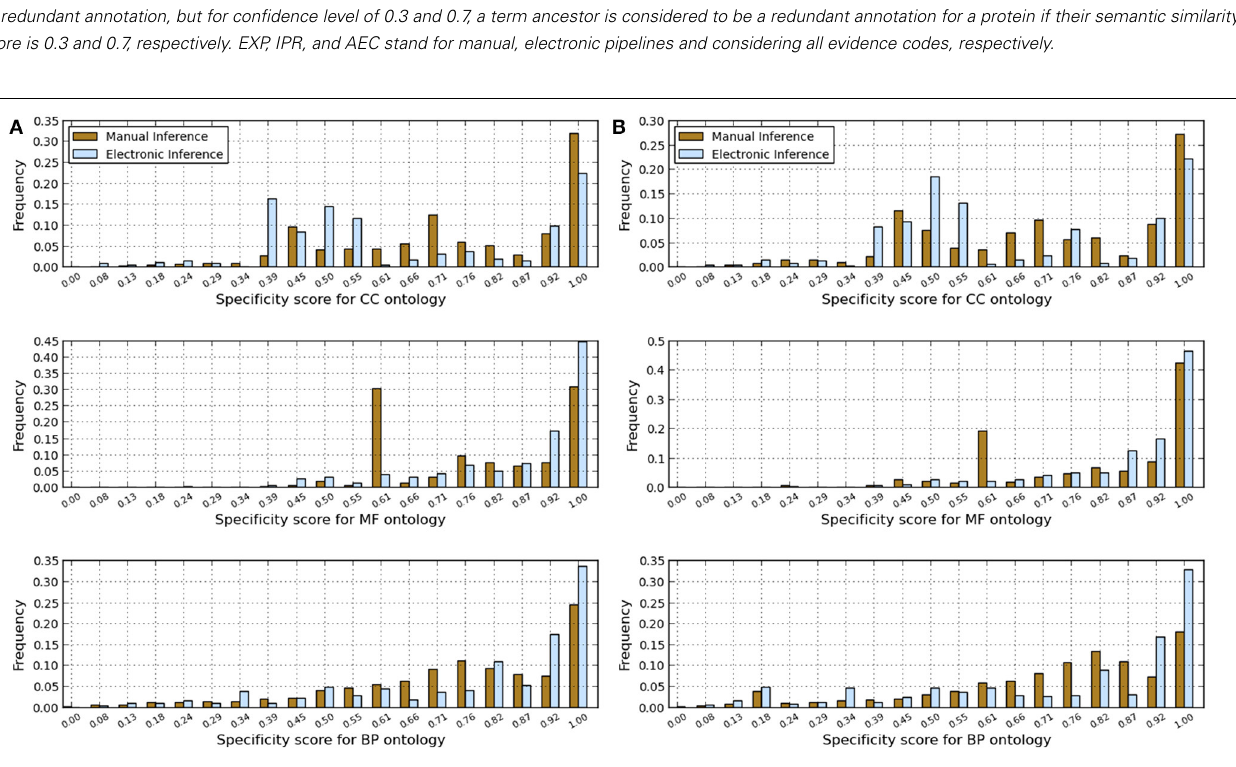
FIGURE 1 | Comparison of annotations inferred manually and electronically in human and fruitfly genomes in terms of annotation specificity score computed using the GO-universal metric. (A) Human genome. (B) Fruitfly